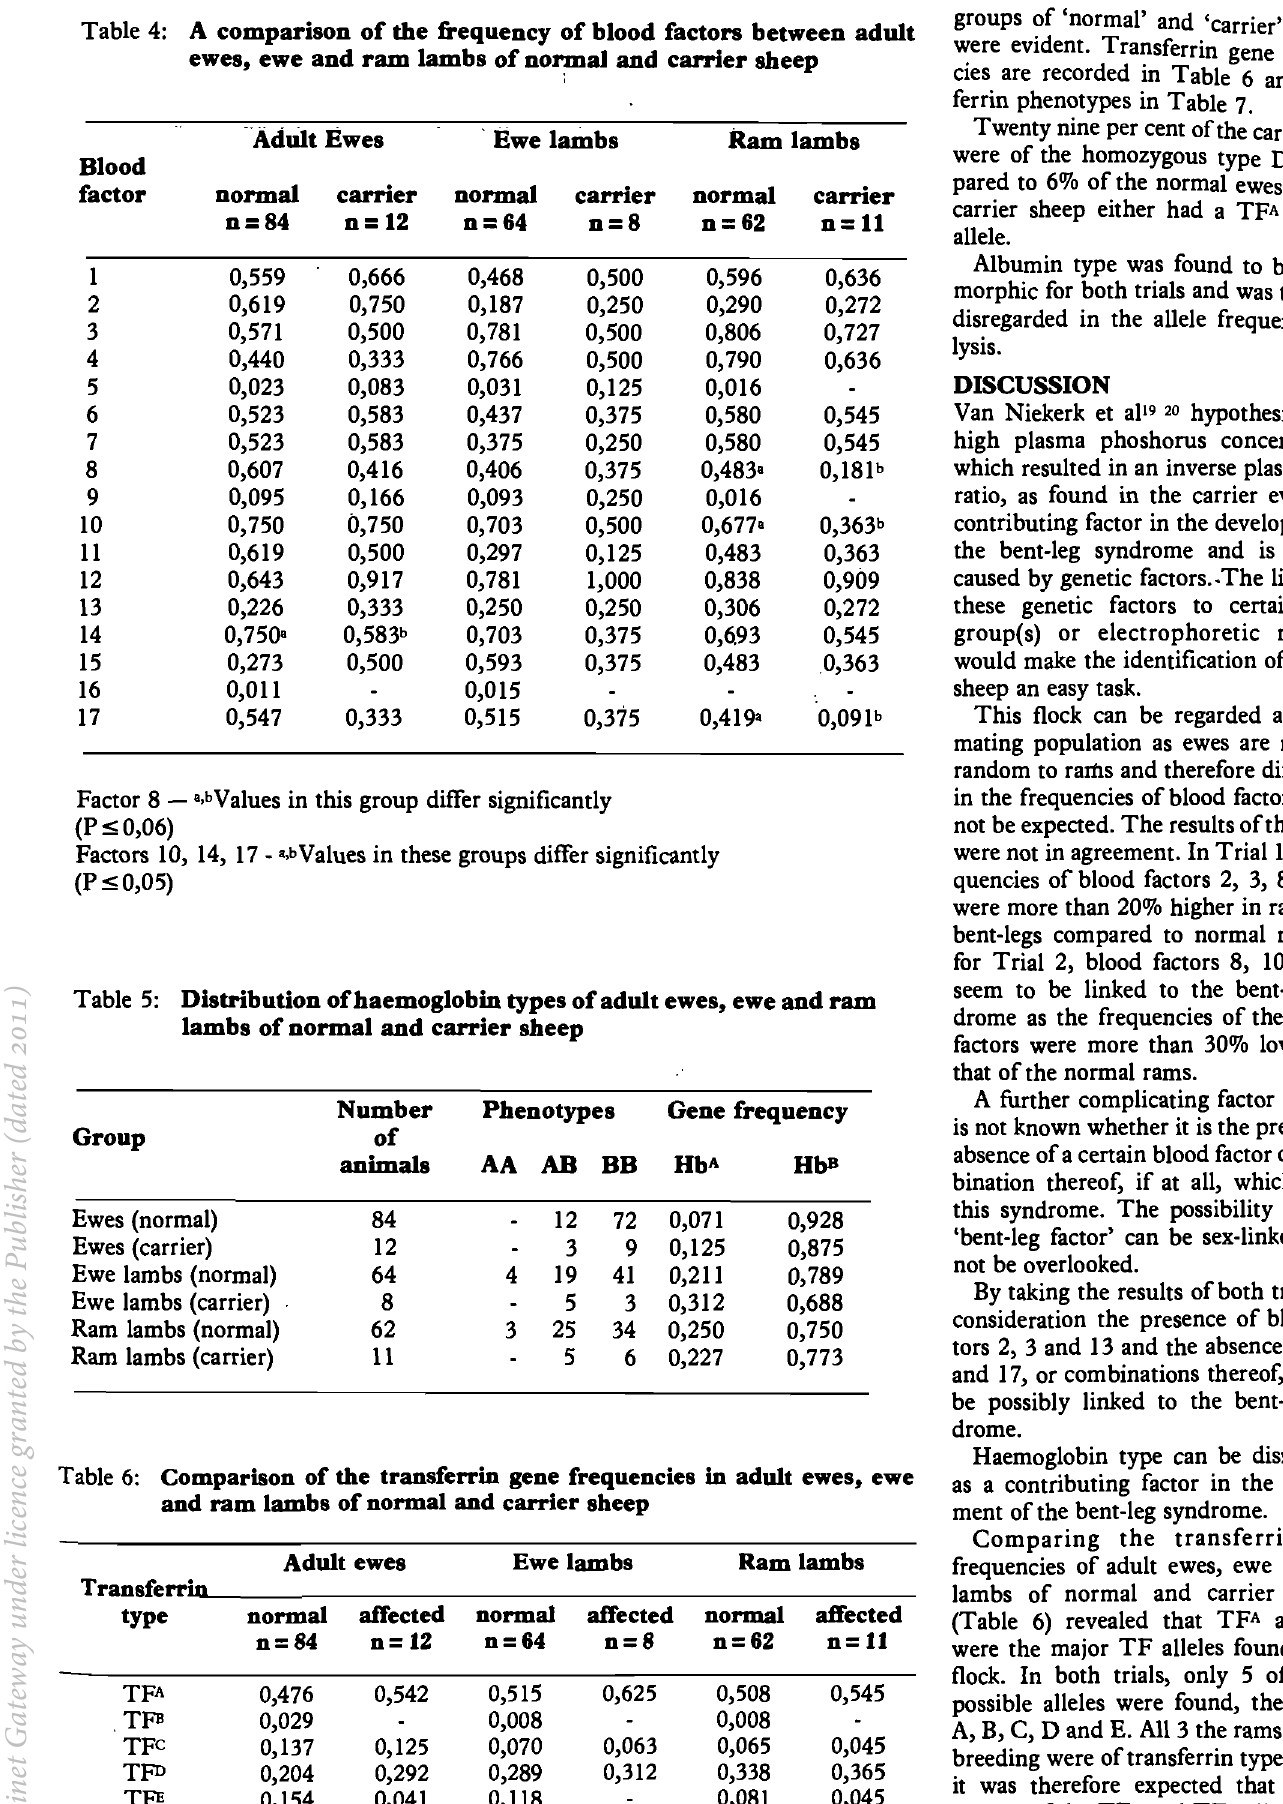
Table 6: Comparison of the transferrin gene frequencies in adult ewes, ewe and ram lambs of normal and carrier sheep Adult